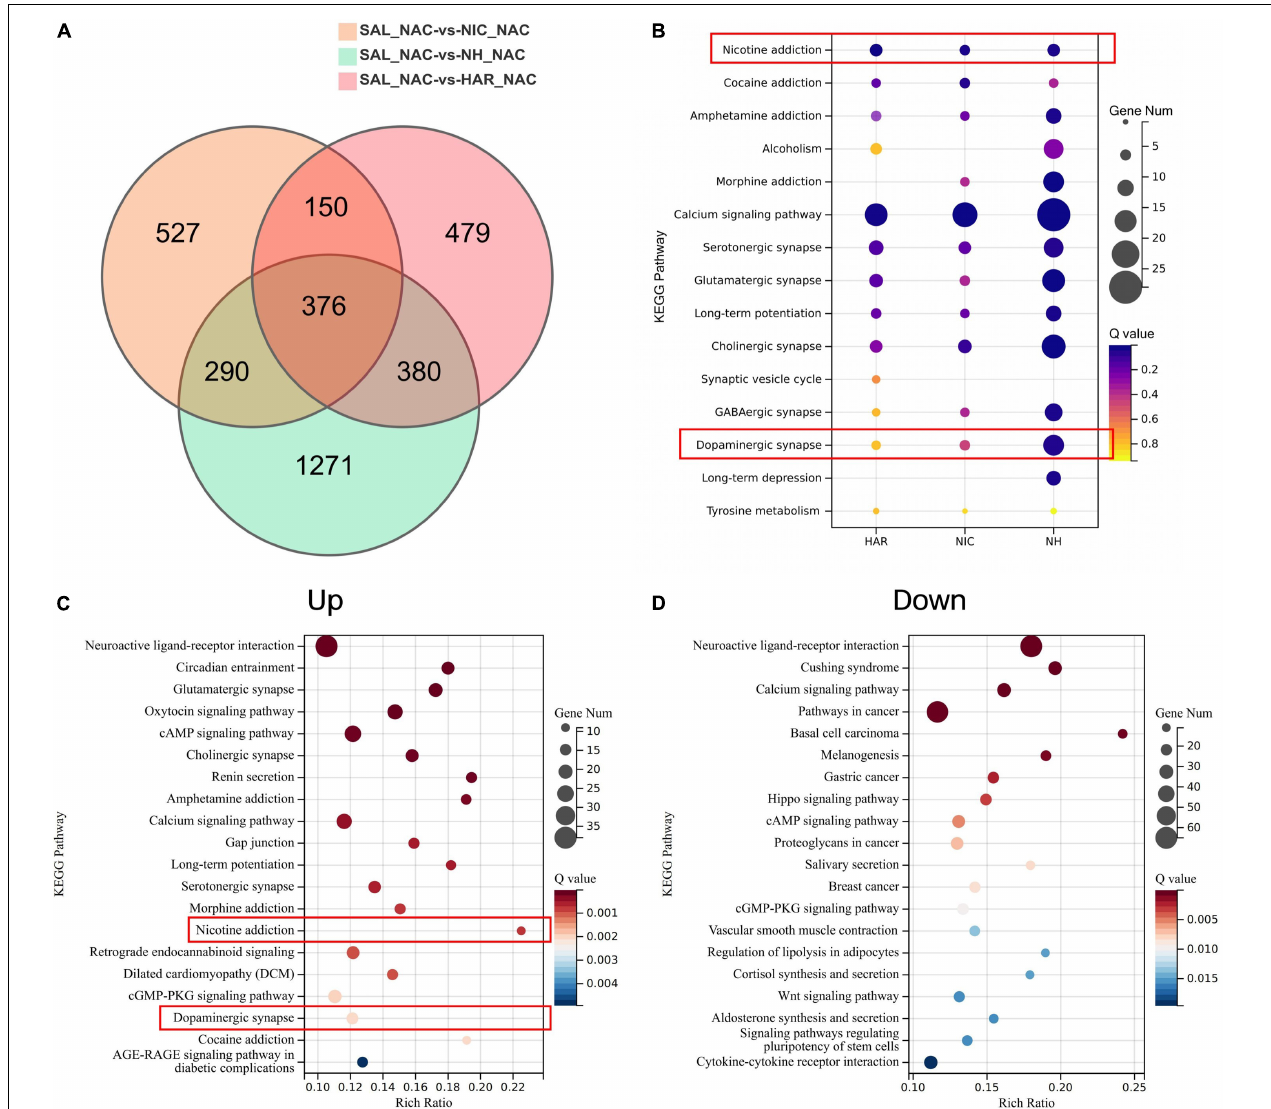
FIGURE 5 | Analysis of differential genes and pathways in the nucleus accumbens transcriptome of self-administered rats. (A) Venn diagram of differential genes in three-group alignment. SAL, HAR, NAC, and NH refer to the S, 1H, N, and N + 1H groups. NAC refers to the nucleus accumbens. (B) Bubble plot of addiction-related pathways enriched for differential genes in the NH group. HAR, NIC, and NH refer to the intersection of HAR and NH (290 + 376), the intersection of NIC and NH (380 + 376), and the non-intersection of NH (1271). Bubble plot of pathways enriched by up-regulated (C) and down-regulated (D) genes in nucleus accumbens of NH